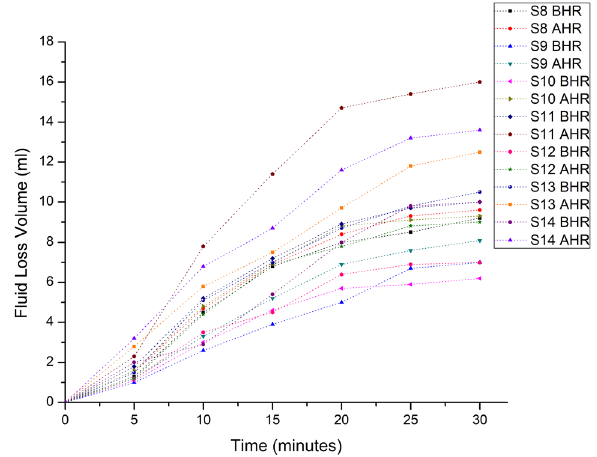
Fig. 7 Gel strength (Gel 10) of all the prepared drilling fluid samples